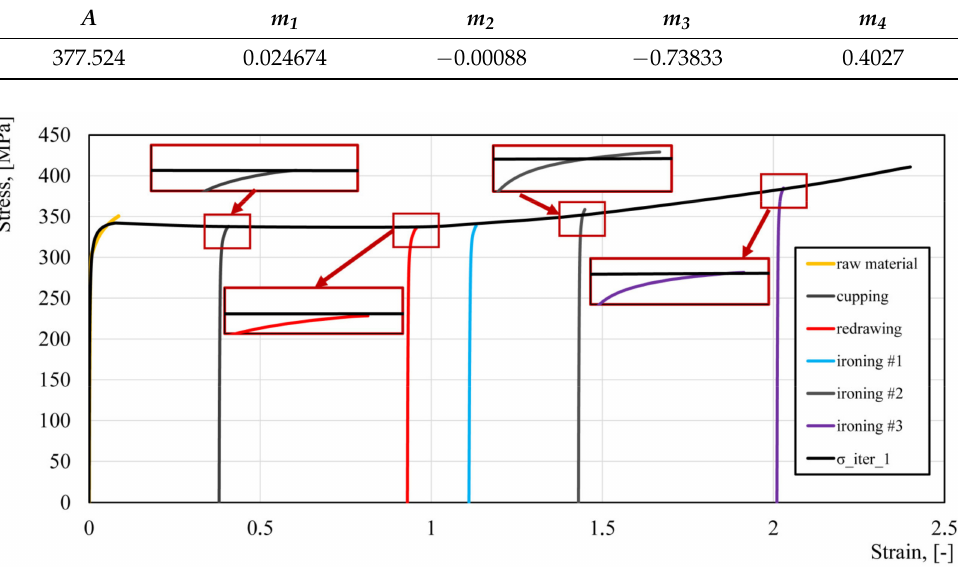
Figure 9. Approximation of the plastometric data for the first iteration of the fitting algorithm.